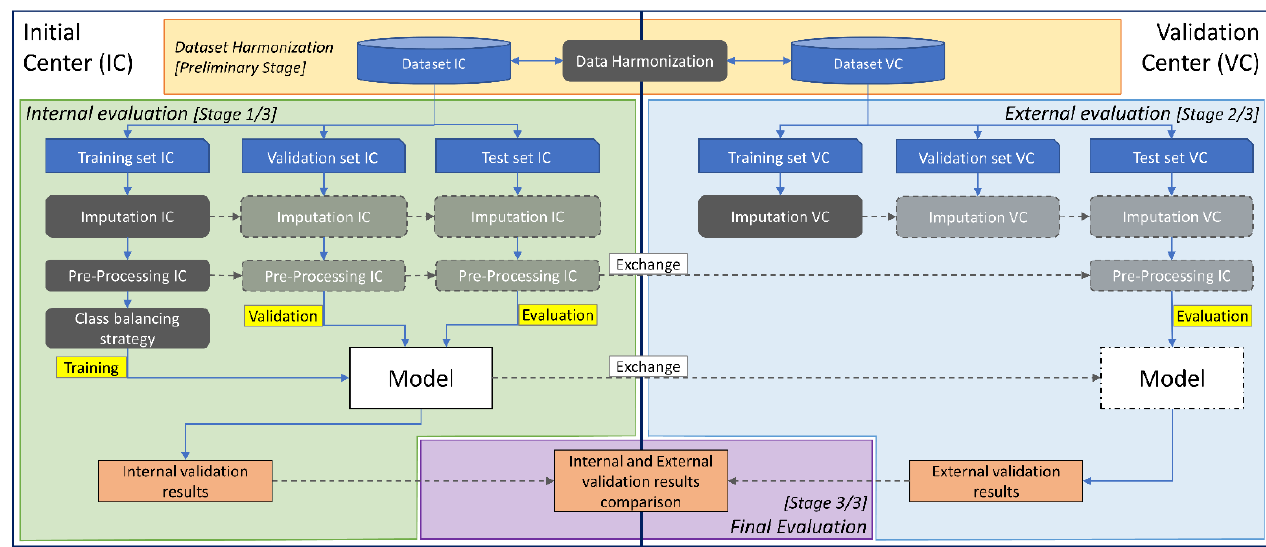
Figure 3. Detailed diagram of the inter-center cross-validation. Training, validation and evaluation are shown in yellow color, while data harmonization, imputation, pre-processing and class-balancing strategy steps are shown in grey color. The inter-center cross-validation protocol is organized in three stages: internal evaluation, external evaluation and final evaluation. The first two stages share a common clinical data processing, a common validation order and evaluation metrics. The internal evaluation stage ( left ) and the external evaluation stage ( right ) share a common processing chain including imputation and pre-processing steps. The final evaluation stage ( bottom ) is the last stage which is necessary to compare the internal validation results with the external validation results. At the first two stages, each model is evaluated, while at the final stage, both internal and external validation results are compared for a final performance assessment.